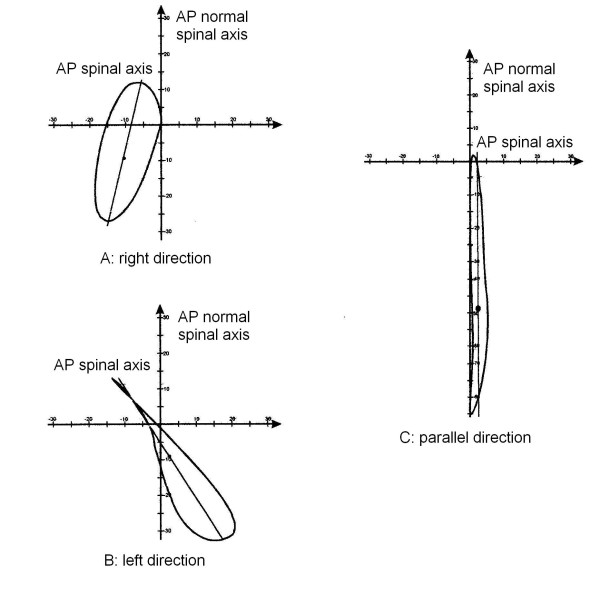
Examples of patients with different Directions. The Direction classificatory parameter is the angle between the AP spinal axis and the AP normal spinal axis (abscissa); it was defined as Direction because it is as if the pathological spine had changed its normal postero-anterior direction with respect to the pelvis, rotating clockwise or anticlockwise. A: right Direction; B: left Direction; C: parallel Direction. For clinical and 3 DEMO complete data of these patients see Appendix [see Additional file 1].